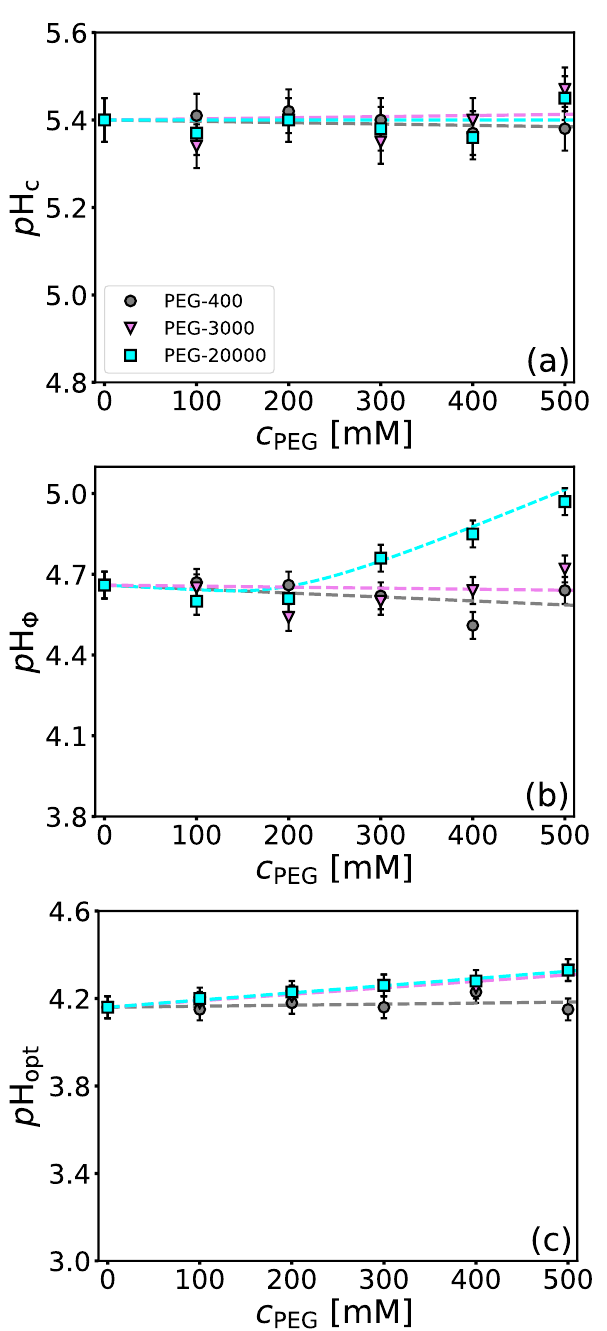
Figure 5. Only high-MW PEG at high concentrations promotes the formation of insoluble protein-PE complexes. Same as in Figure 3 but for PEG-400, PEG-3000, and PEG-20000: ( a ) p H c , ( b ) p H Φ , and ( c ) p H opt